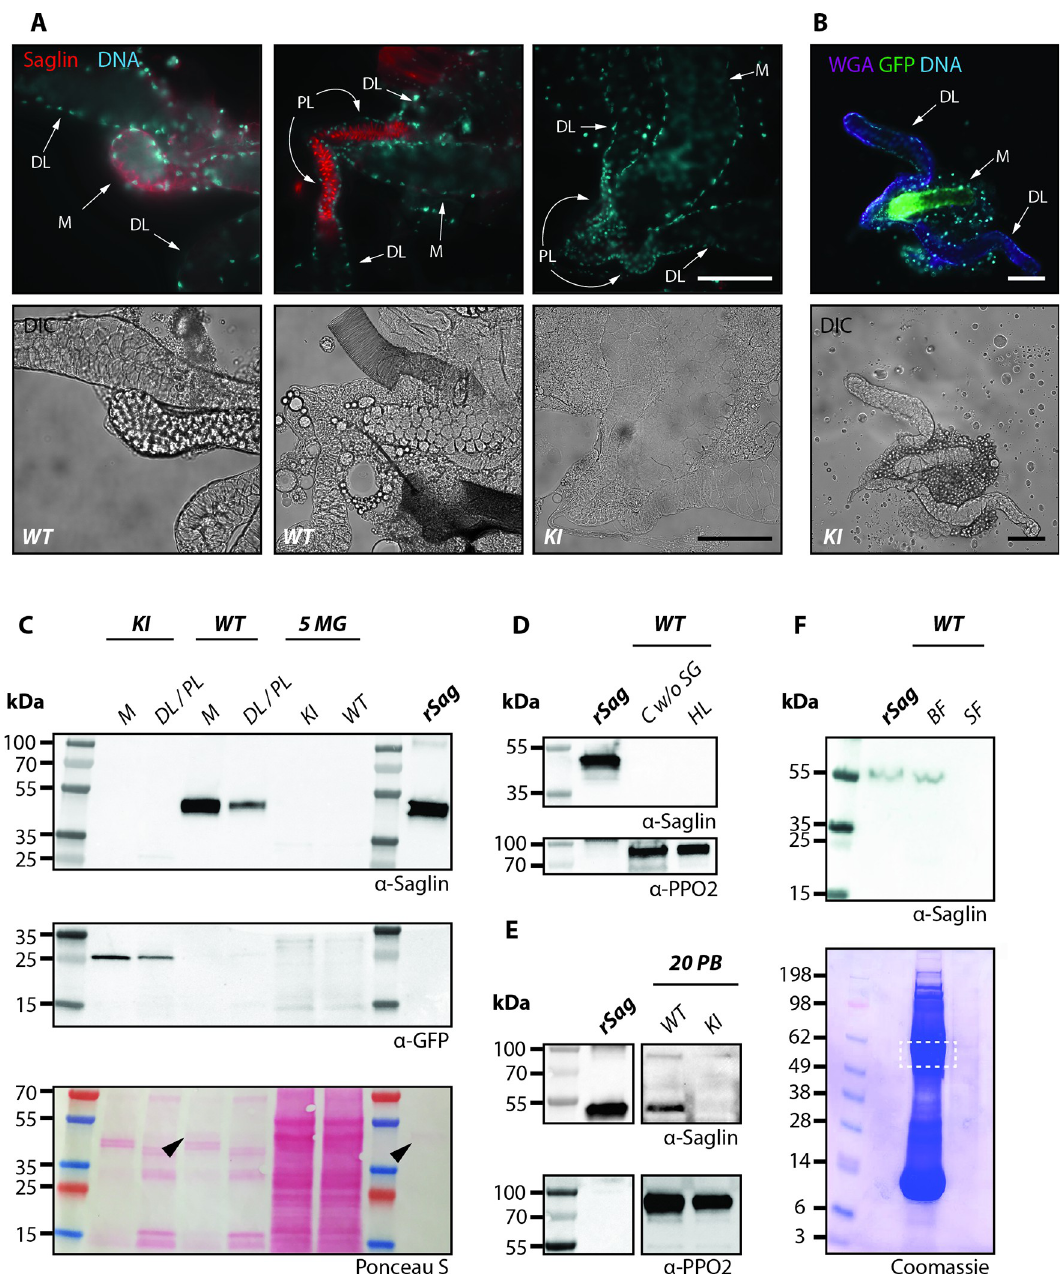
Fig 5. Saglin protein is found in the salivary glands, excreted with saliva and re-ingested with the blood meal. A) Immunofluorescence staining of Saglin in fixed wild-type ( Ngousso ) and sag(-)KI salivary glands. Saglin (red) and DNA (cyan) stainings (top), and differential interference contrast (DIC, bottom). Images depict the same salivary glands. DL: distal-lateral lobes; PL: proximal-lateral lobes; M: median lobe. Scale bar: 100 μ m. WT: wild-type. KI : sag(-)KI . B) Staining with fluorophore coupled wheat germ hemaglutinin (WGA) of a sag(-)KI salivary gland ex vivo . WGA staining in purple, DNA in cyan and EGFP expression under the control of the saglin promoter in green. Scale bar: 100 μ m. C-F) Western blots of different mosquito tissues to detect the presence of Saglin. C ) Median (M) and distal-lateral/proximal-lateral lobes (DL/PL) in comparison to unfed midguts (MG) of the same wild-type ( WT) and sag(-)KI (KI) mosquitoes. Arrowheads indicate Saglin size in wild-type median lobes and recombinant Saglin lanes on the Ponceau S stained blot. D ) Carcasses with salivary glands removed and hemolymph of wild-type. E ) Proboscis of wild-type and sag(-)KI (PB). Two different images of the same blot to account for removed lanes. F ) Bolus of sugar (SF) and blood fed (BF) wild-type midguts. The dashed square indicates the area where Saglin is expected to localize in the Coomassie stain. For all Western blots, recombinant Saglin (rSag) was used as positive control. Western blots and SDS-Page gels were treated with α -PPO2 antibodies or Ponceau S, and Coomassie blue, respectively, to assess loading of